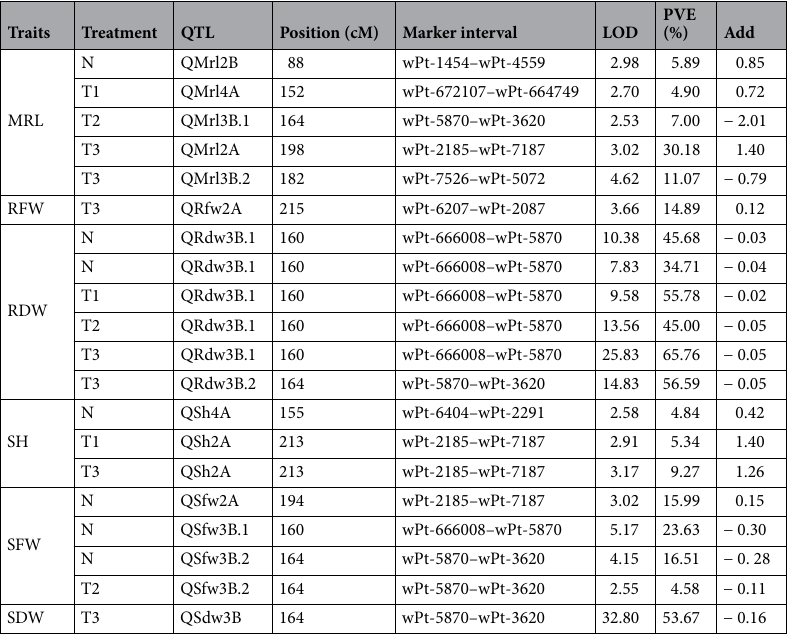
Table 4. QTLs with additive effects of traits related to seedling growth detected in the RILs under the N, T1, T2 and T3 conditions. N, T1, T2 and T3 are the same as in Table 2.